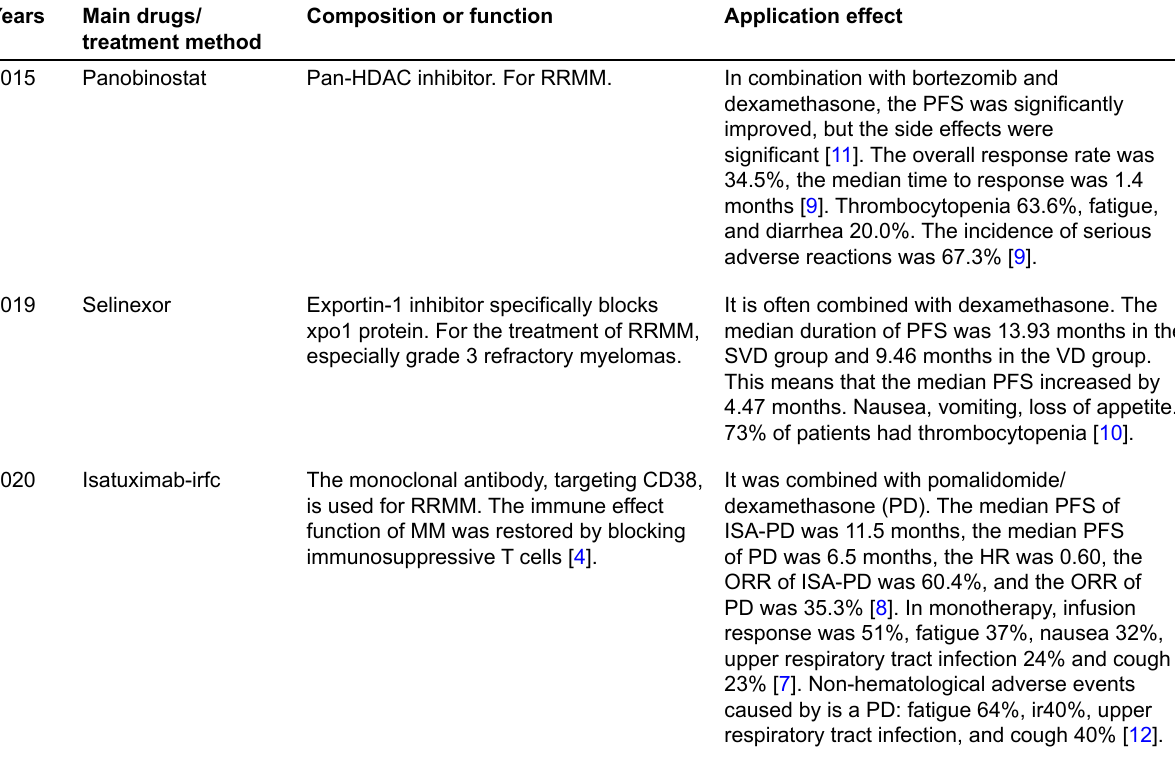
Table 1 . The current drugs and treatment methods for MM ( continued